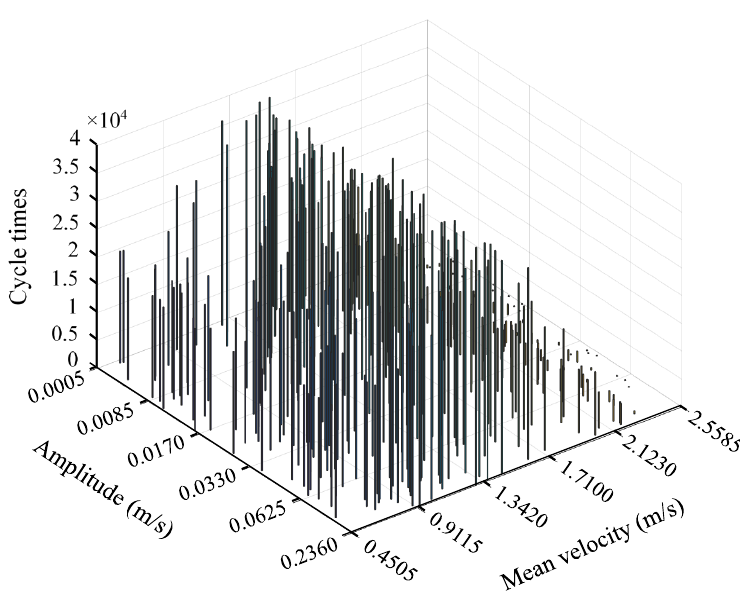
Figure 9. Annual statistics of turbulence cycles.